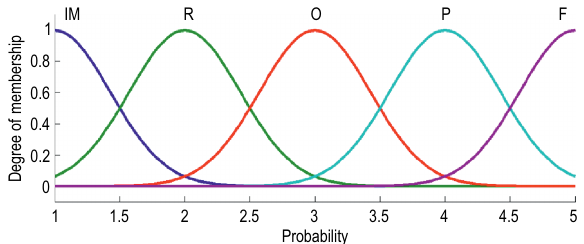
Fig. 4. Membership function for probability of occurrence